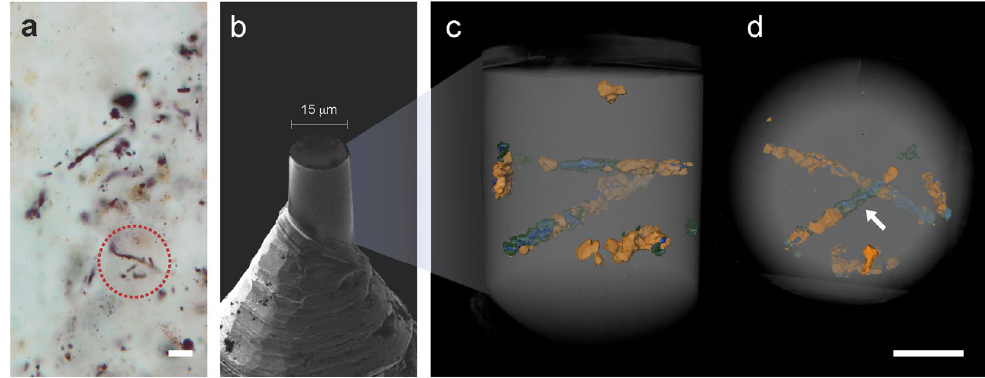
Figure 3. Fossilized filamentous microorganisms from the Mink Mountain locality viewed by different imaging methods. ( a ) Optical photomicrograph of filamentous microfossils apparently preserved as a red-brown iron oxide. The circle indicates the region selected for PXCT analysis. ( b ) SEM micrograph of pillar sample prepared by FIB-SEM attached atop a PXCT pin. ( c,d ) 3D renderings (side and top views, respectively) of PXCT data showing the distribution of fossil filaments in the interior of the pillar. The view in ( d) corresponds to the same orientation as the outlined region shown in ( a ). The white arrow indicates one of the kerogenous regions (green/ blue) that is invisible in the optical microscopy shown in ( a ). The structures in orange represent the only visible features resolved by optical microscopy and correspond to euhedral and anhedral maghemite crystals. Scale bars: 5 μ m.